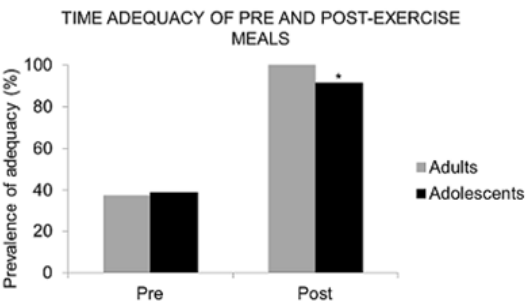
Figure 4. Number of meals, interval between meals, meal omission, snack omission, and time adequacy of pre and post-training meals, before and after nutritional counselling. The red lines indicate the recommendations of at least five meals a day (number of meals) and a maximum of three hours between meals (interval between meals). * p < 0.05, pre versus post. † p < 0.05, adults versus adolescents.